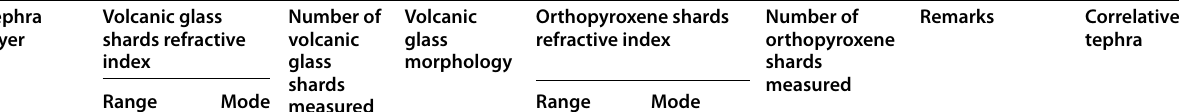
Table 3 Results of tephra analysis for T1 and T6